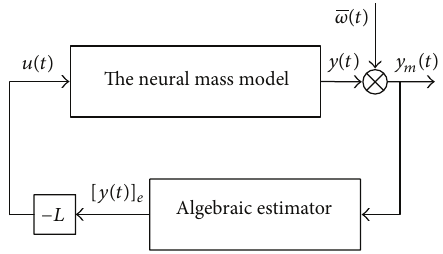
Figure 3: The proposed control based on algebraic estimation.